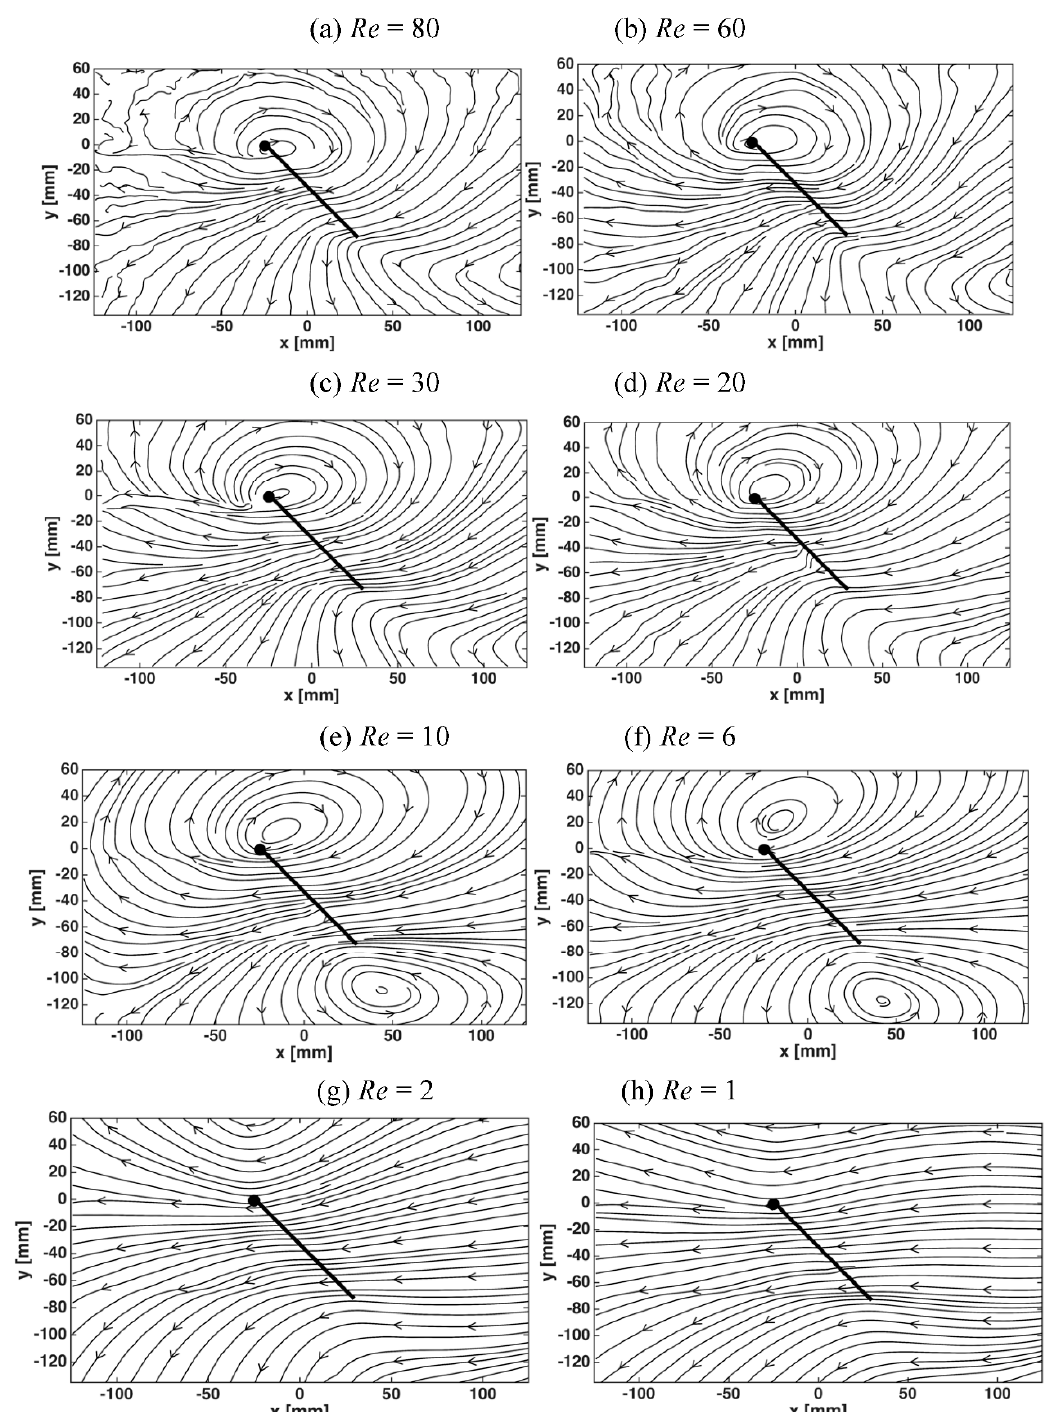
Figure 6. The streamlines of flows generated by revolving the dynamically scaled wing, obtained from DPIV measurements (45° angle of attack, Re range from 1 to 80). The light sheets were located at mid-span and parallel to the chord when the wing position was at 90° of the revolution stroke. Note that the wing is traveling to the left.